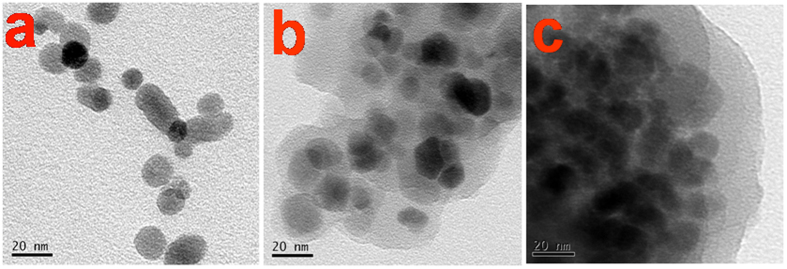
TEM images of (a) Fe3O4 NPs, (b) Fe3O4@PDA core-shell NPs and (c) AgNPs-Fe3O4@PDA.